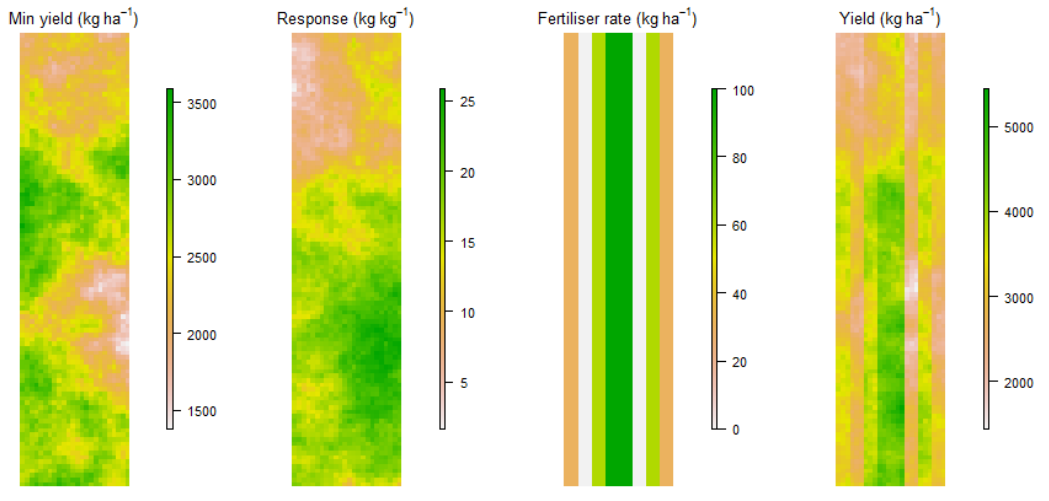
Figure 3. Simulation of locally varying linear response.